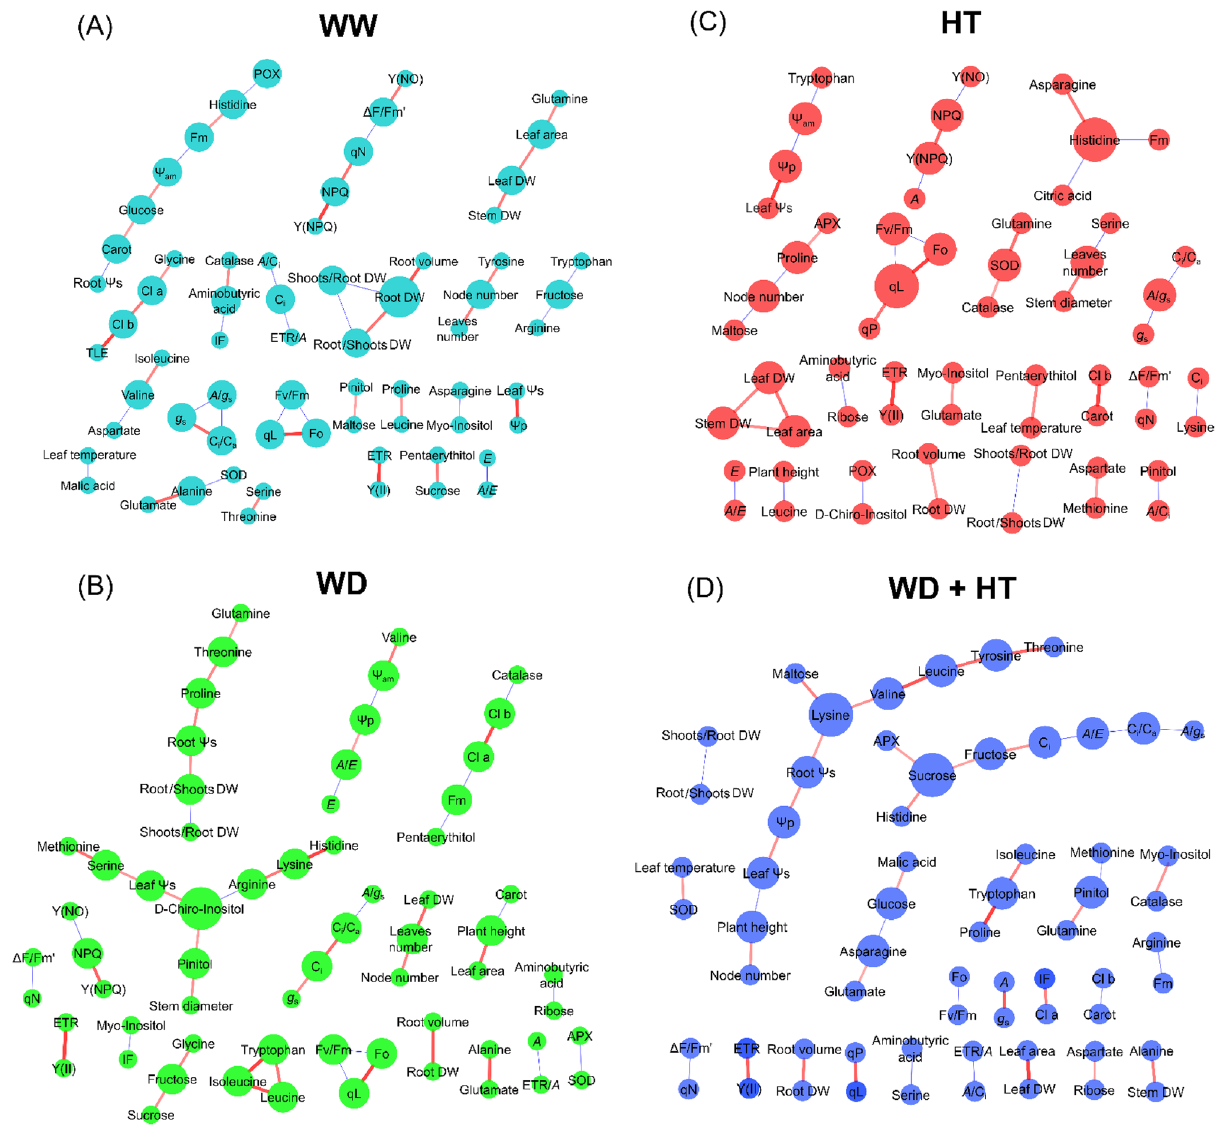
Figure 8. Correlation-based networks of soybean plants maintained for 8 days under ( A ) well-watered (WW; 100% holding water capacity HWC, 25 °C), ( B ) water deficit (WD; 40% HWC, 25 °C), ( C ) high temperature (HT; 100% HWC, 40 °C) and ( D ) water deficit plus high temperature (WD + HT; 40% HWC; 40 °C) conditions. The networks were created by combining data from anatomical, metabolic, and physiological levels. The nodes are the parameters and the link is the debiased sparse partial correlation coefficient (DSPC) among them, whenever is significant ( p < 0.05). Red and blue links correspond to positive and negative correlations among the nodes. The thickness and the intensity of the colour of the links indicate a higher DSPC coefficient, in the module. Bigger nodes indicate a higher degree of connection. This analysis was performed using CorrelationCalculator software and the networks were designed by using MetScape on CYTOSCAPE software ( n =